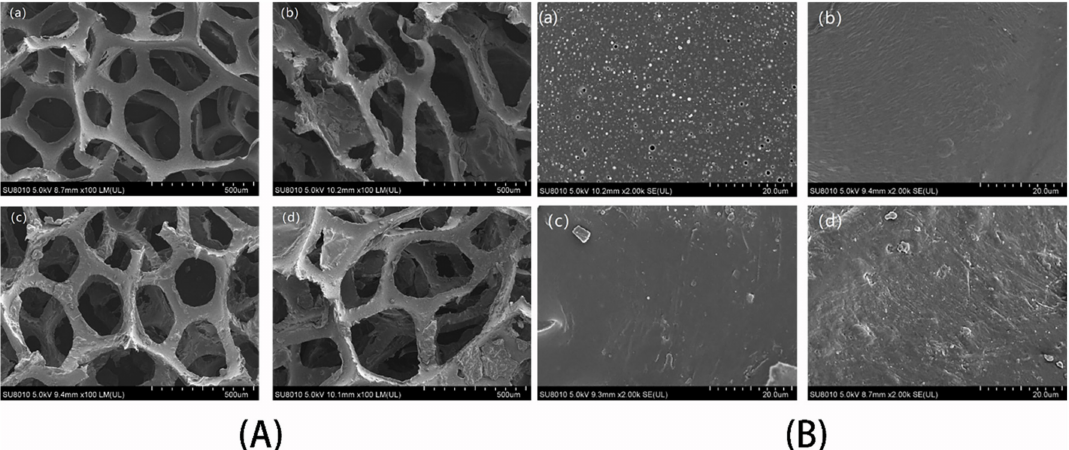
Figure 3. Low magnification ( A ) and high magnification ( B ) Scanning electron microscopy (SEM) images of ( a ) pre- treated sponge, ( b ) octadecyldimethyltrimethoxysilylpropylammonium chloride-CNTs/PU, ( c ) hexadecyltrimethoxylsilane- CNTs/PU, and ( d ) OTS-CNTs/PU with coupling time = 24